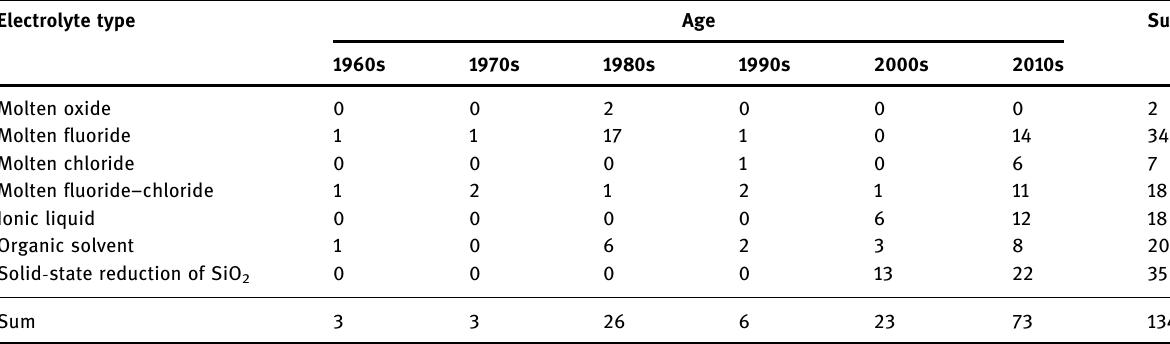
Table 9: Trend of scienti fi c papers reported on electrochemical production of Si Electrolyte type